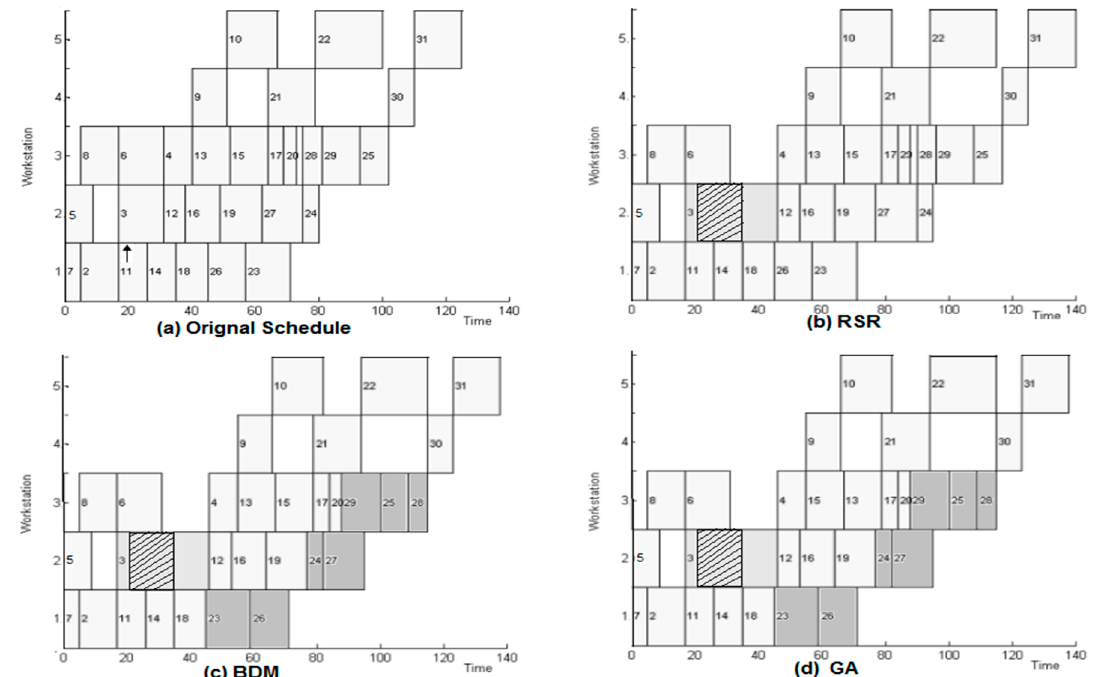
Figure 6. Gan tt chart for operations rescheduling. Figure 6. Gantt chart for operations rescheduling.